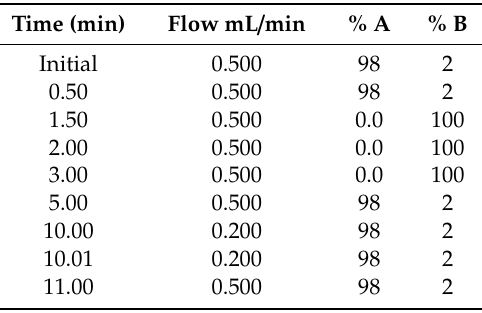
Table A2. Activation gradient for C18